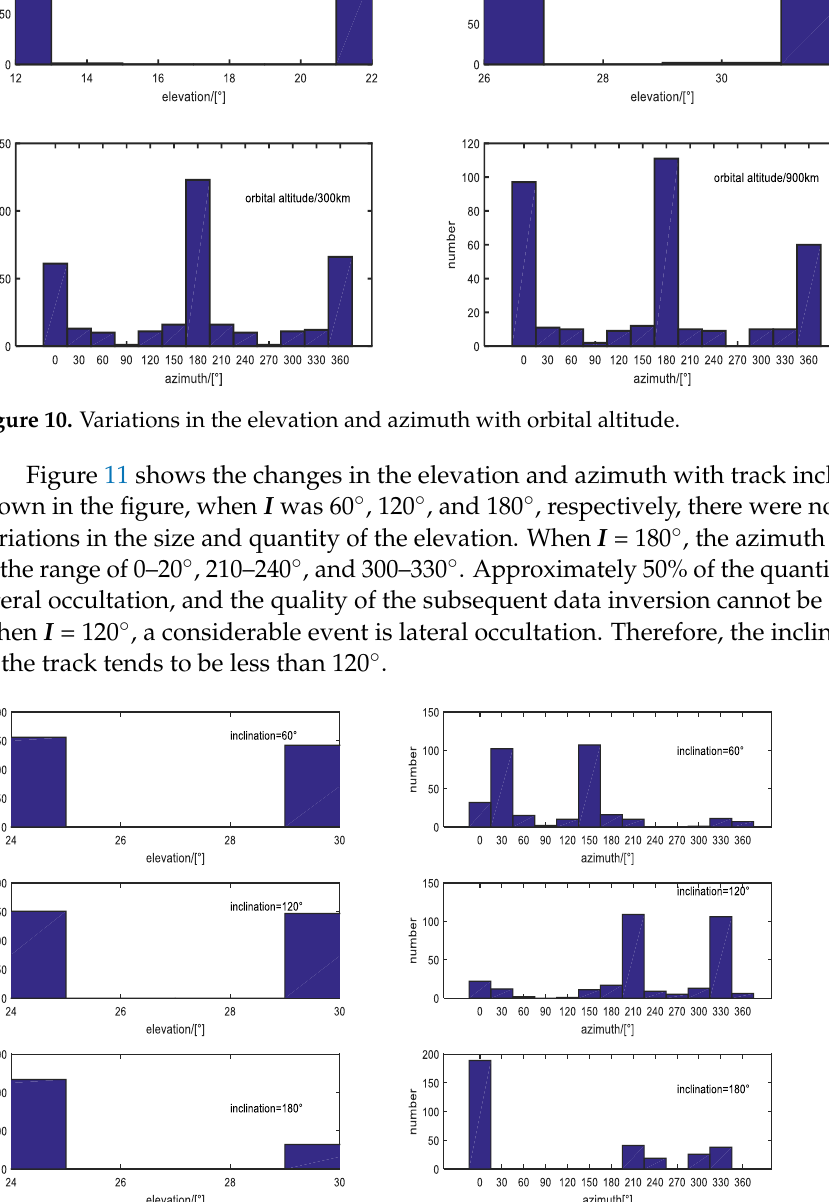
Figure 11. Variations in the elevation angle and azimuth with orbital inclination.